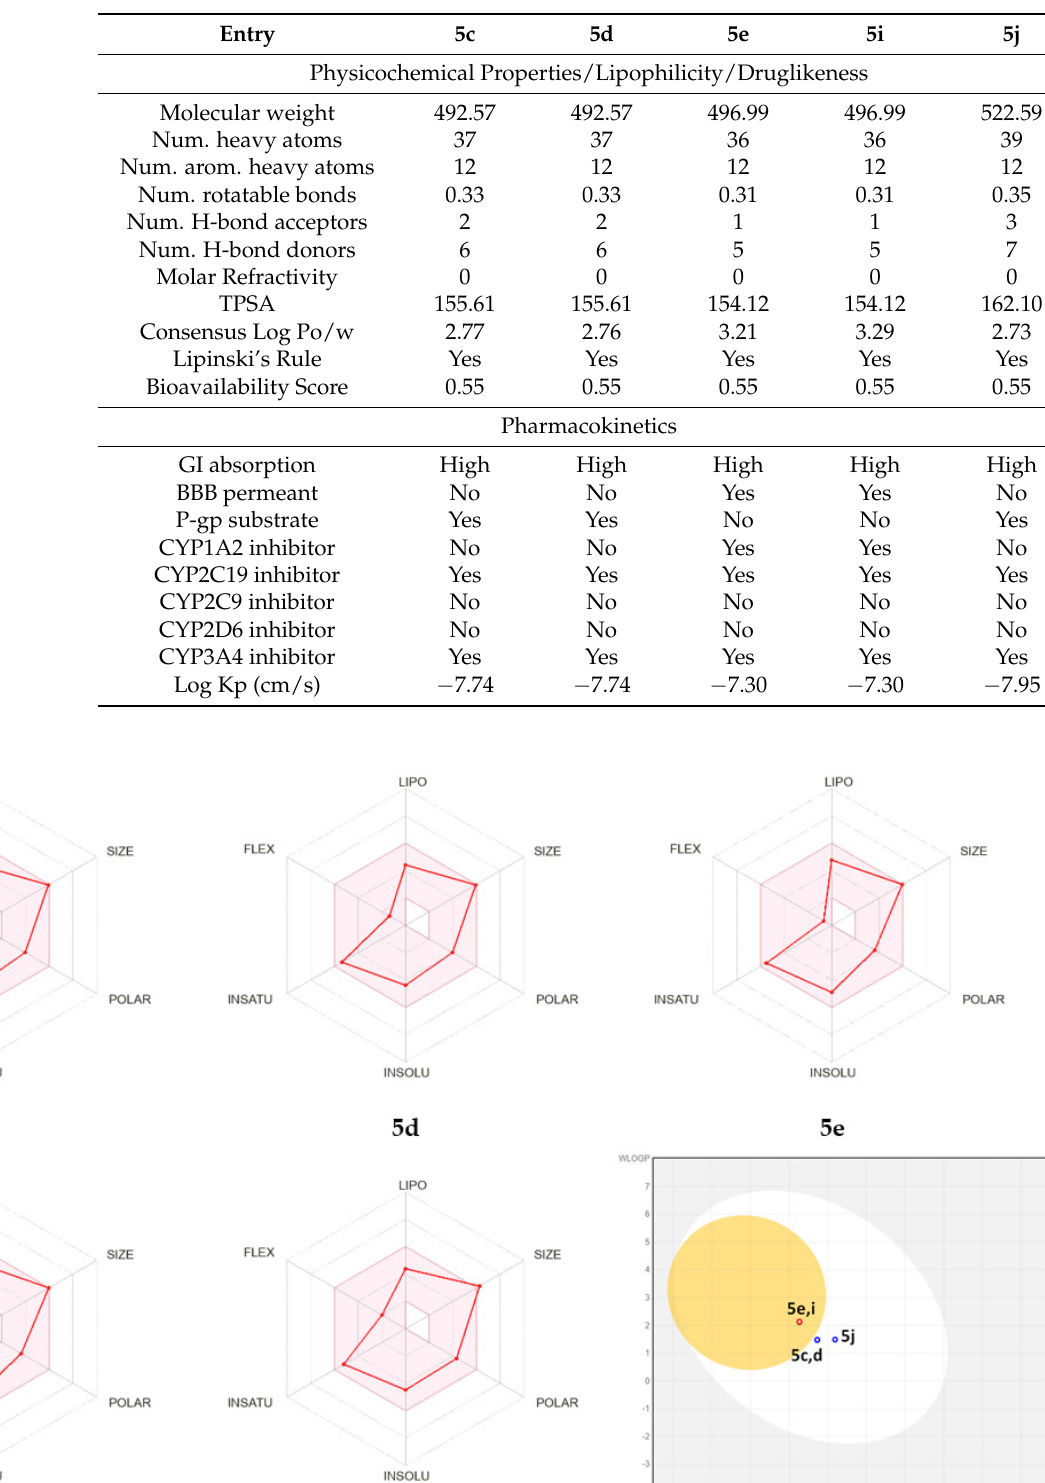
Table 4. ADME properties of potent synthesized compounds.